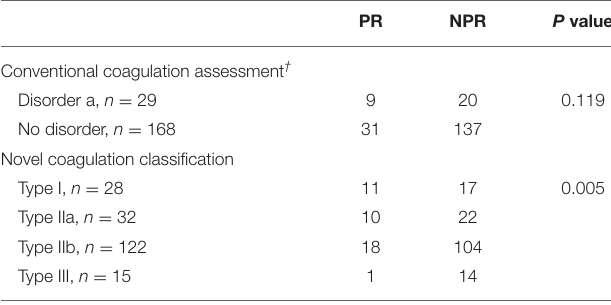
TABLE 4 | Comparison of conventional coagulation assessment and novel coagulation